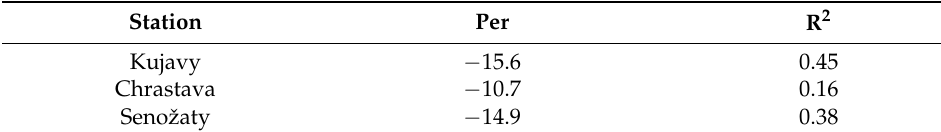
Table 2. Linear trends for the beginning of flowering of the Brassica napus at individual phenological stations during the 1991–2012 period (Per) including coefficients of determination R 2 . Stations are listed by